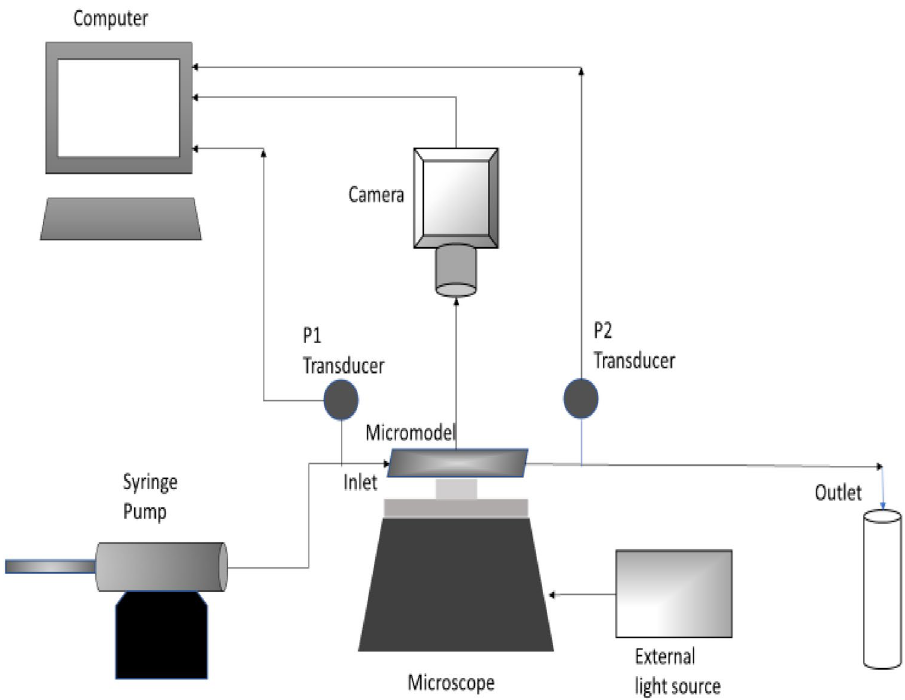
Fig. 1 General schematic of a microfluidic experimental set